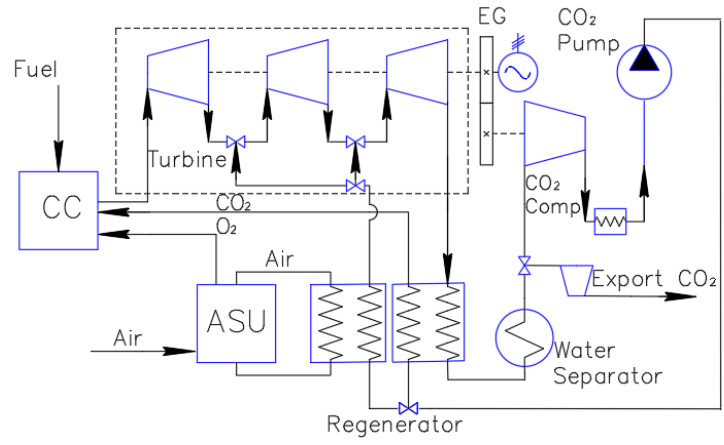
Figure 2. Allam cycle with two heat exchanger regeneration scheme.